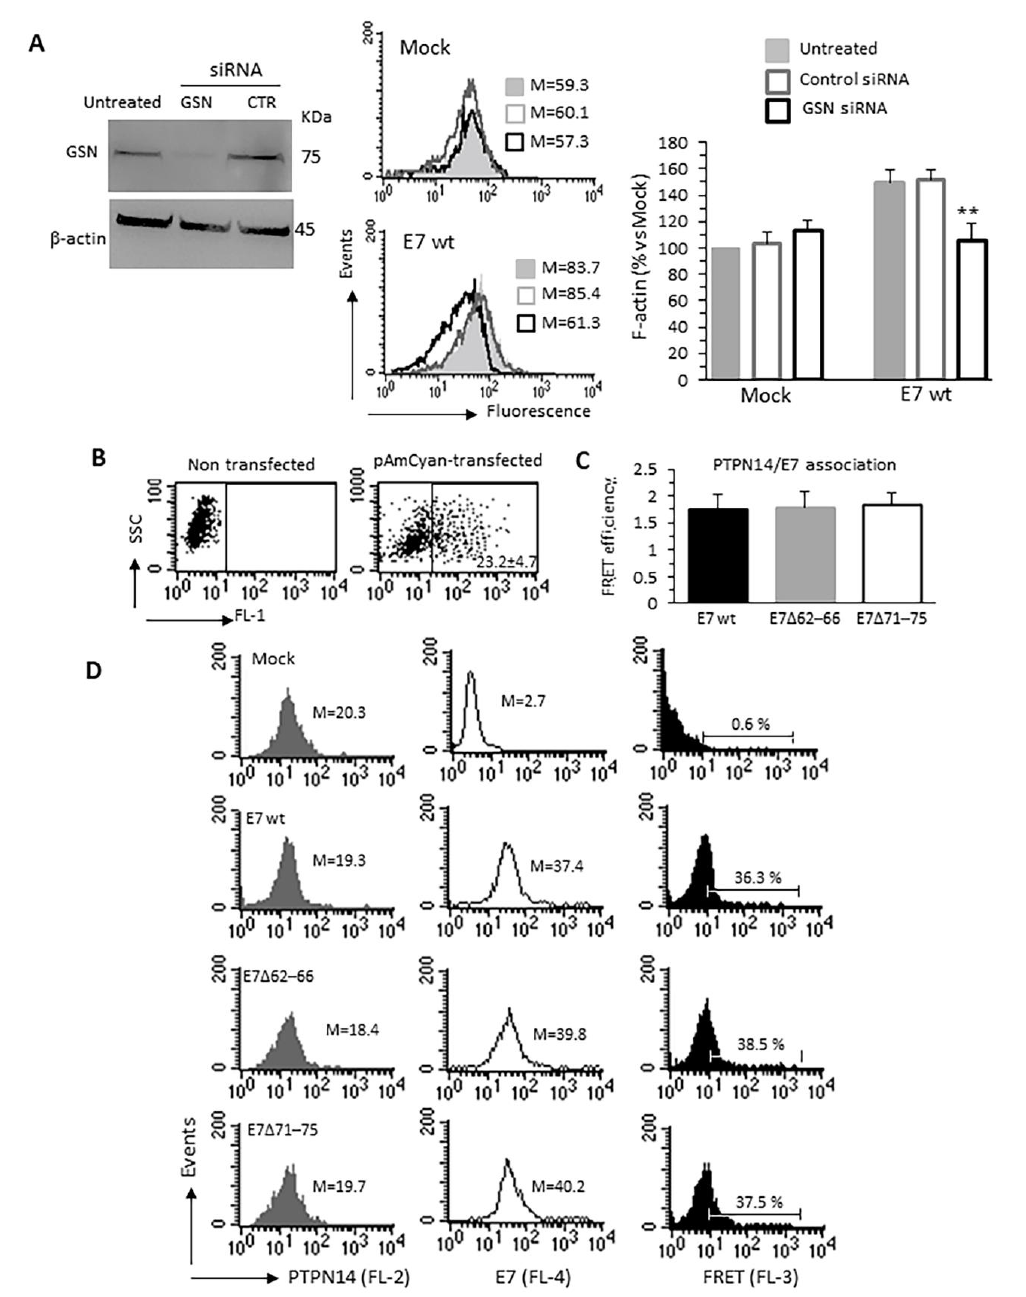
Figure 4. Specific relevance of E7-GSN interaction. ( A ) Representative western blot of endogenous gelsolin (GSN) knock- down showing the relative abundance of GSN in pAmCyan trasfected cells (Mock), in transfected cells treated with specific siRNAs for GSN silencing (siRNAGSN) or treated with scrambled siRNAs as a negative control (siRNAcontrol) (left). Flow cytometry evaluation of the intracellular amount of F-actin restricted to pAmCyan-positive cells transfected with siRNAGSN or scrambled siRNA as control. Histograms obtained in a representative experiment are shown. Bar graph (right) shows the mean ± SD of the median fluorescence intensity obtained in four different experiments. ** p < 0.01 and *** p < 0.001 vs. Mock transfected cells. ( B – D ) Quantitative evaluation of PTPN14/E7 molecular association by FRET technique. ( B ) Flow cytometry analysis was restricted to pAmCyan-positive cells (reported as percentage). Bar graph in ( C ) shows FRET efficiency calculated according to the Riemann’s algorithm. Data are reported as mean ± SD from three independent acquisitions. ( D ) Cytofluorimetric histograms obtained in one experiment representative of three. Numbers in the first and second columns indicate the median fluorescence intensity of the respective proteins, the percentage in the third column represent FL3 positive events. Uncropped western blot images for Figure 4A are available in Supplementary Figure